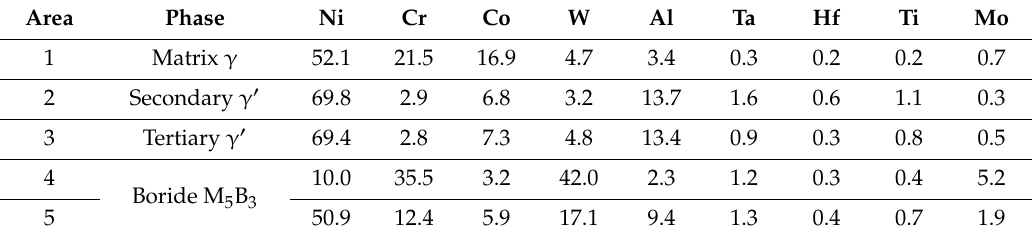
Figure 13. Distribution of selected alloying elements in a dendritic region, STEM-EDX. Table 5. Chemical composition of the precipitates in dendritic regions, STEM-EDX,